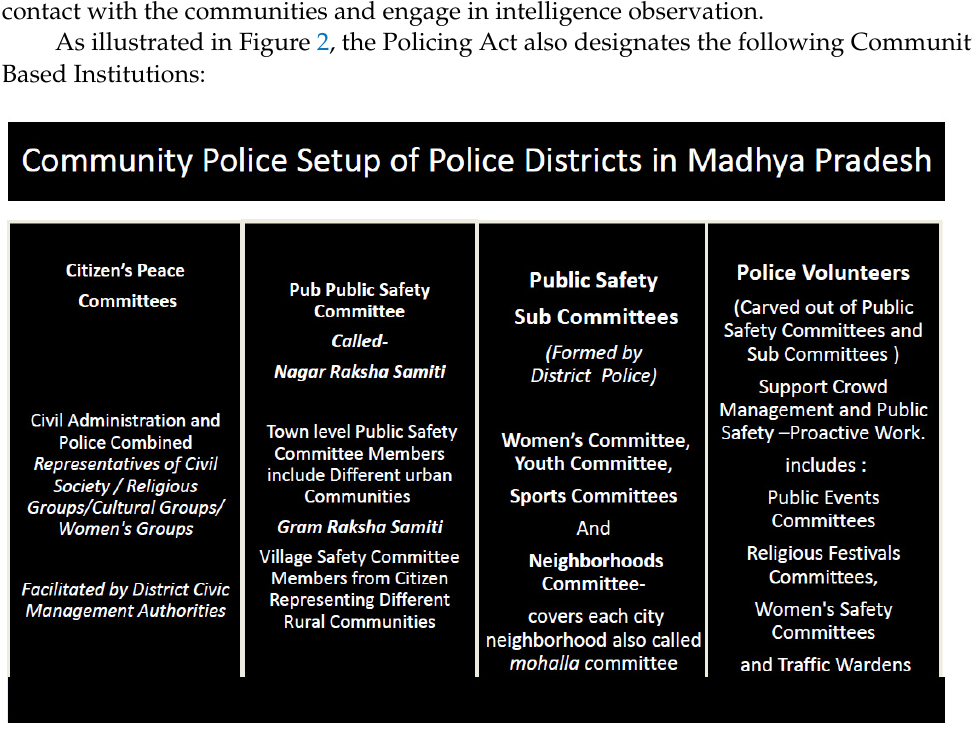
Figure 2. District Policing and Community-based Police Structure.